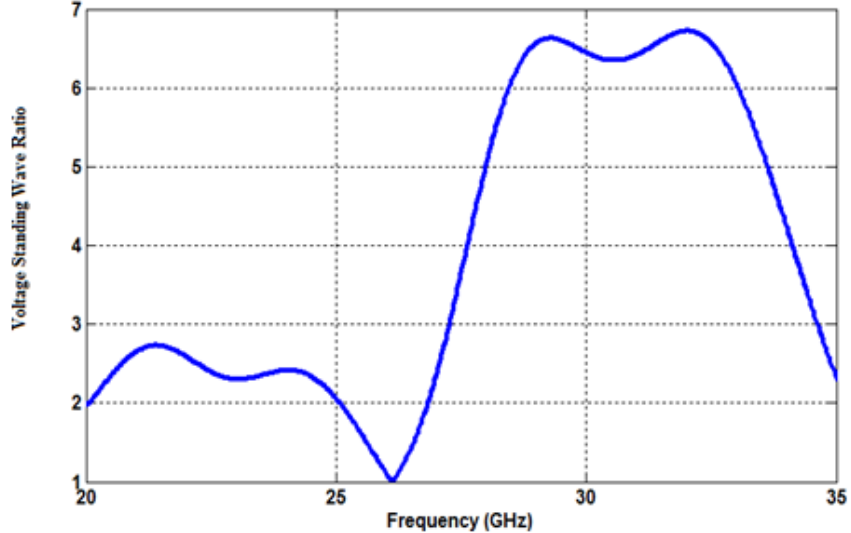
Figure 5. Voltage standing wave ratio (VSWR) values of the single element antenna.